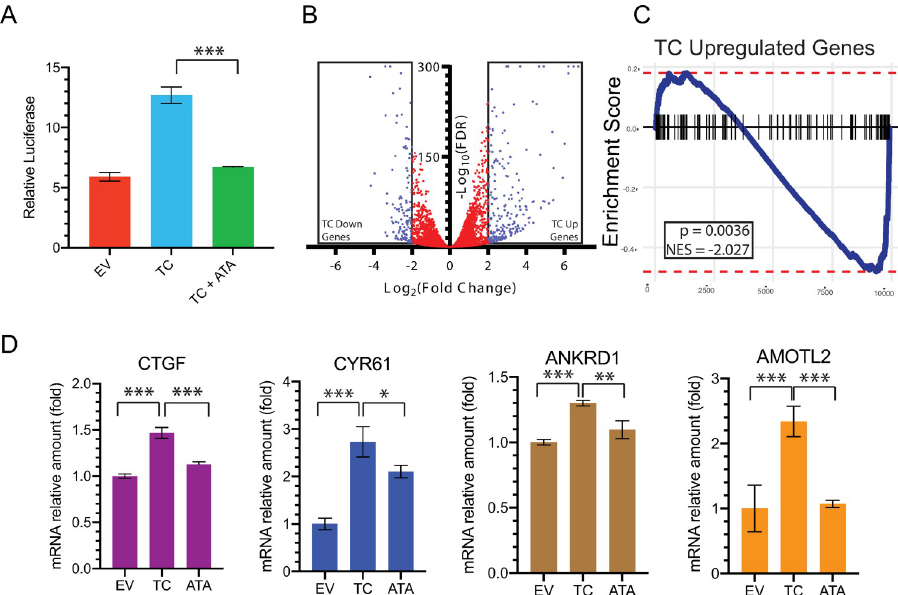
Fig 3. ATA inhibits TC/TEAD transcriptional activity. A, TC/TEAD reporter assay to measure TC/TEAD activity in cells transfected with empty vector (EV), cells stably expressing TC treated with vehicle control (TC), and TC- expressing cells treated with ATA (TC + ATA). The experiment was repeated three times and similar results were obtained. Data are presented as mean ± SD. B, Volcano plot showing the distribution of differentially expressed genes in TC-transfected compared to EV-transfected cells, blue points: FDR < 0.05 and either Log 2 FC > 2 or Log 2 FC < -2, red points: FDR > 0.05 or 2 < Log 2 FC > -2, FDR: False discovery rate. C, Gene set enrichment analysis of ATA-treated cells stably expressing TC versus TC-expressing, vehicle control treated cells utilizing the TC up Genes from Fig 3B, NES: Normalized enrichment score D, qPCR to probe the levels of indicated target genes in empty EV, TC and TC +ATA NIH3T3 cells. Error bars represent the standard deviation of the mean (n = 3) normalized to EV, P values were obtained through two-tailed t tests ( ��� P < 0.0008, �� P < 0.008, � P <